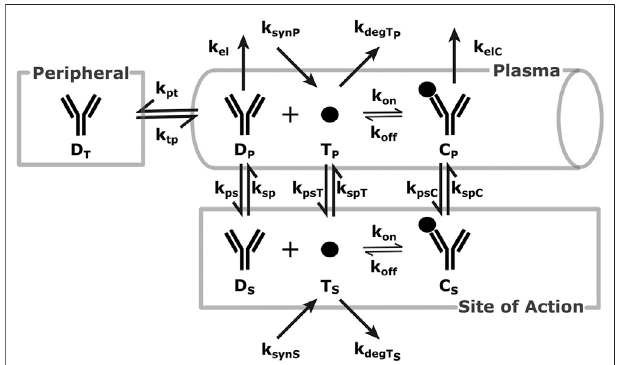
FIGURE 1 | SoA Model Scheme: A diagram describing the distribution and elimination of the mAb (denoted by D), synthesis, distribution and elimination of the target (denoted by T) and the interactions between the mAb and target and the distribution and elimination of the resulting mAb: target complex (denoted by C). Subscripts describe the compartments - p for plasma,tfor peripheral tissues, sforthesite ofaction. Detailed descriptions of all variables and parameters are in Model Structure and Methods of Parametrization and Table 1